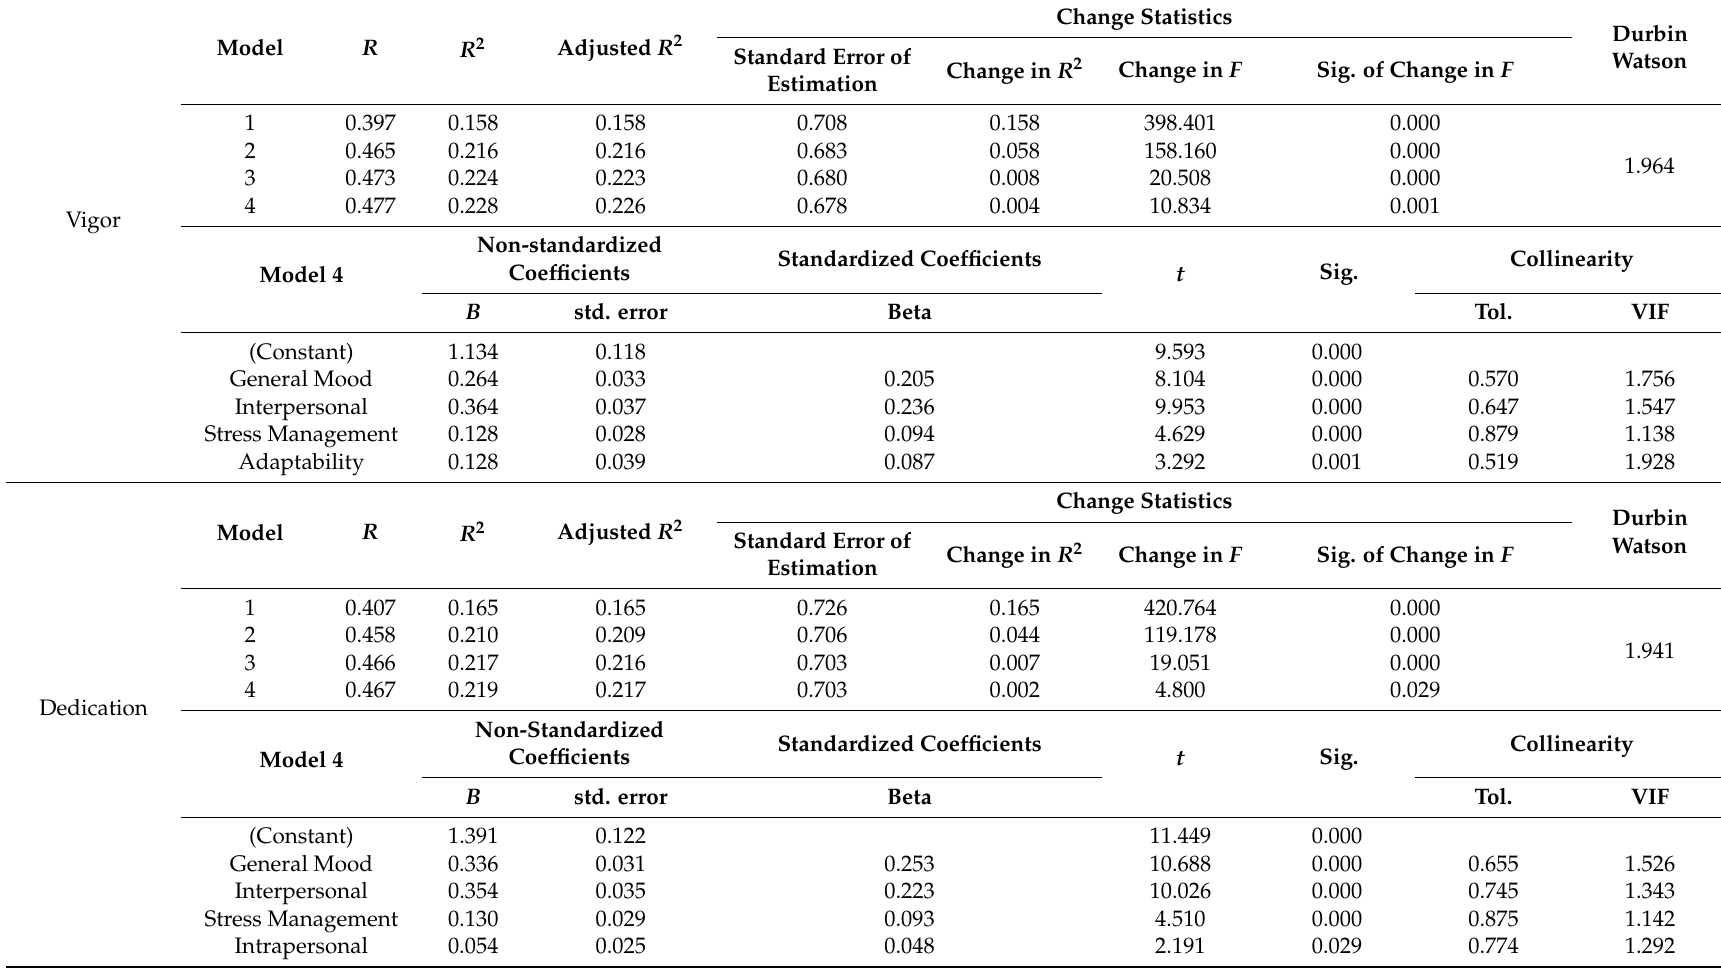
Table 2. Multiple stepwise linear regression model ( N =